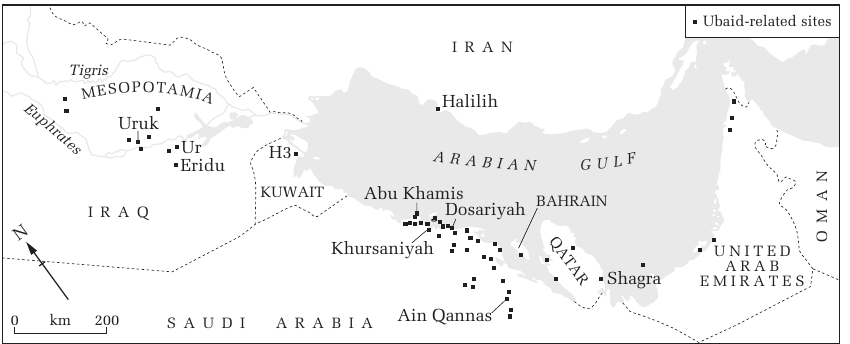
Figure 1 Mesopotamia and the Arabian Gulf, showing the distribution of Ubaid (Meso- potamia) and Neolithic (Gulf) sites of the sixth and fifth millennia BC ; only those sites mentioned in the text are named. Lack of systematic archaeological survey probably accounts for the apparent absence of sites in the area north and south of H3 and in coastal Iran. H3 is over 250km from the southern edge of the Ubaid area in Mesopotamia and may be part of an undiscovered complex of sites that linked Mesopotamia and the